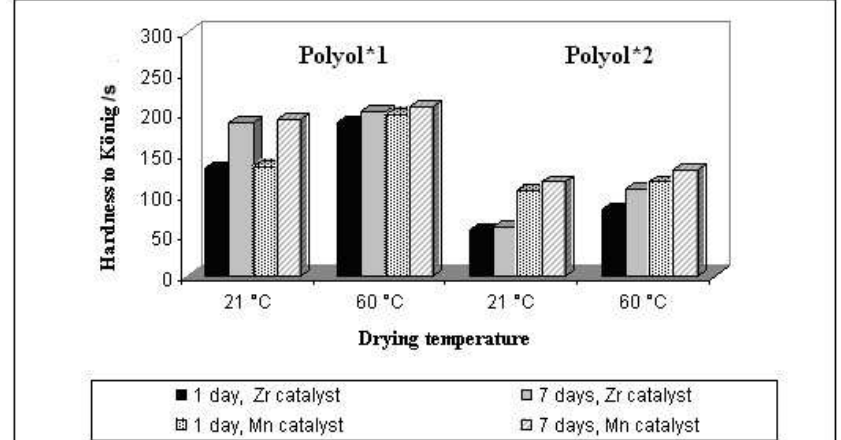
Figure 6. Dependence of the hardness development on the drying conditions, with the applied zirconium catalyst K-KAT ® XC-6212 and the manganese based catalyst (applied on a glass plate, 30 µm dry film